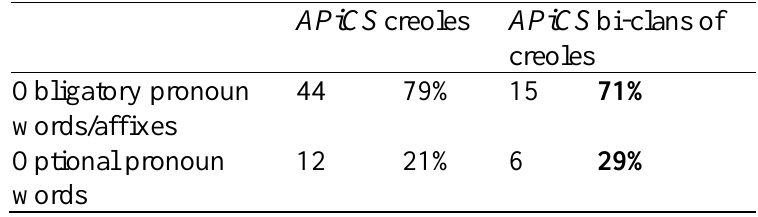
Table 5. Expression of pronominal subjects